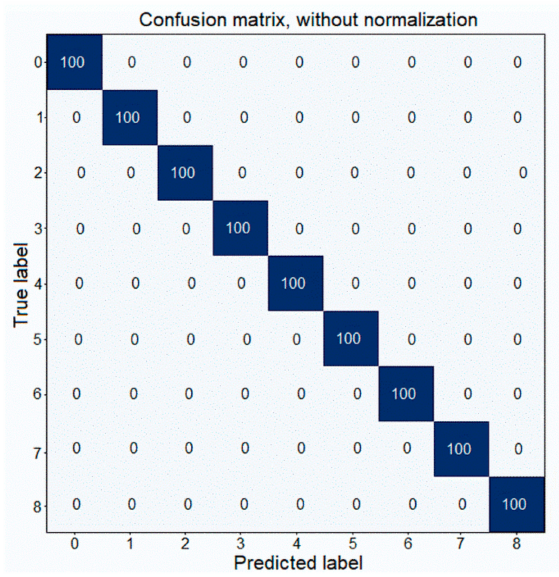
Figure 8. Confusion matrix reached for all